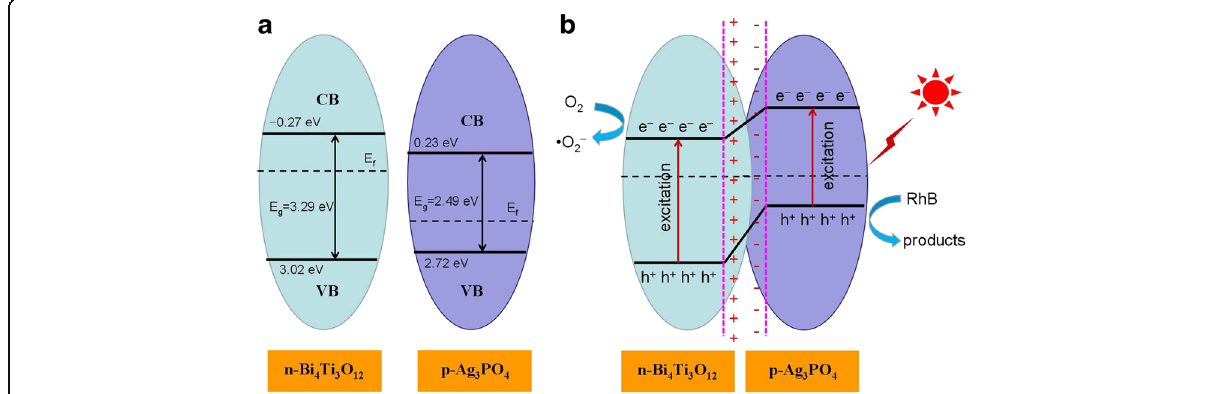
Fig. 12 Schematic illustration of the energy band structures for a separate Bi 4 Ti 3 O 12 and Ag 3 PO 4 and b Bi 4 Ti 3 O 12 /Ag 3 PO 4